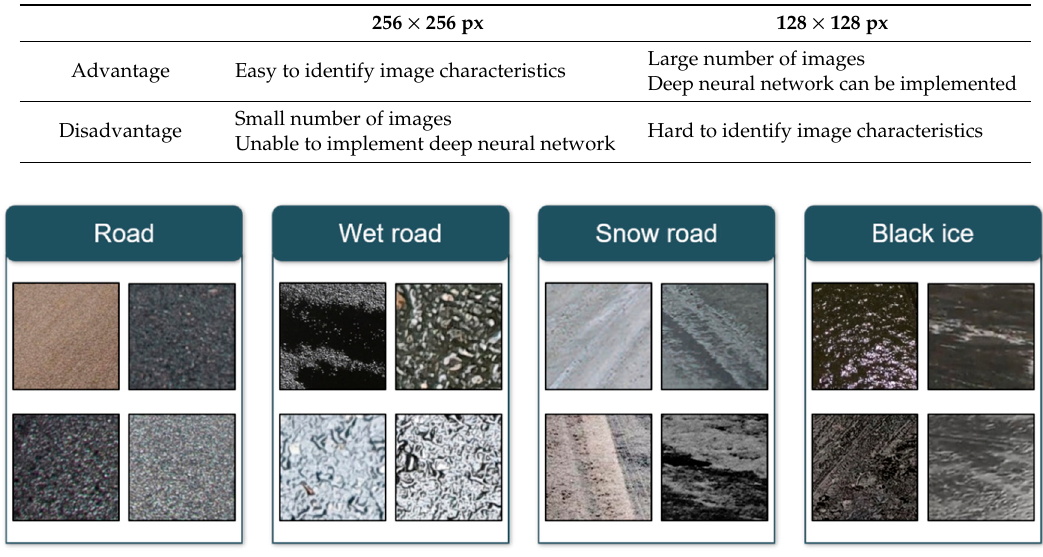
Table 2. (Dis) advantage by data size.